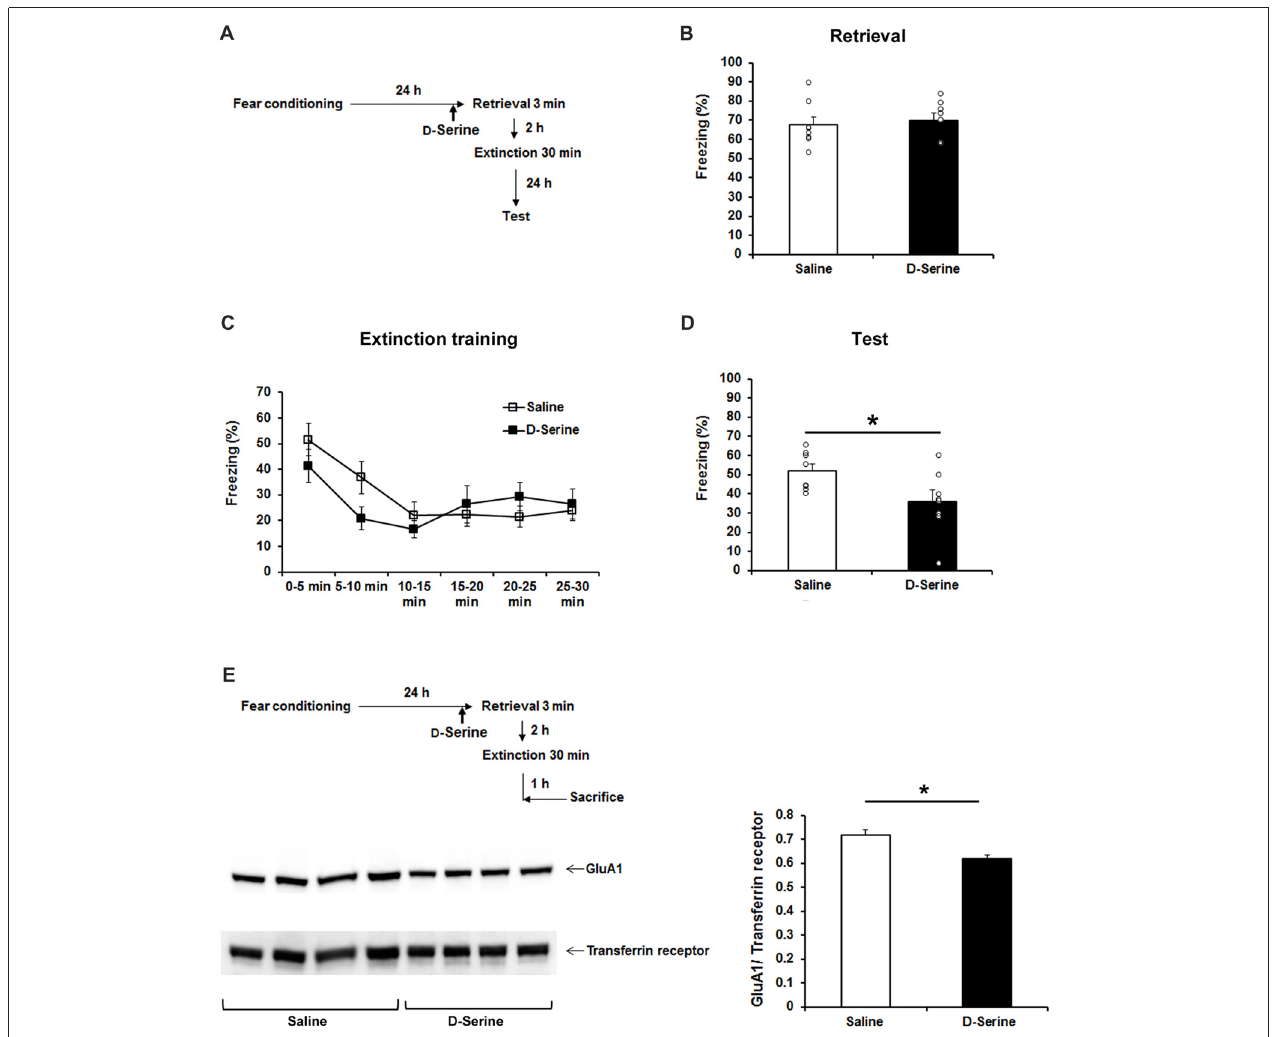
FIGURE 6 | D -Serine treatment rescues the deficit of P-RE in the SRRKO mice. (A) Experimental schedule for the behavioral rescue experiment. (B) D -Serine-treated SRRKO mice ( n = 8, D -Serine) exhibited similar levels of freezing compared with saline-treated SRRKO mice ( n = 8, Saline) during the 3-min retrieval session. (C) During the extinction training conducted 2 h after retrieval, there was no significant difference in within-session extinction between D -serine- and saline-treated SRRKO mice. (D) During the recall test of extinction memory, D -serine-treated SRRKO mice exhibited significantly lower levels of freezing than did the saline-treated SRRKO mice ( ∗ p < 0.05). (E) Western blot analysis revealed a significantly lower level of GluA1 in the synaptic membrane fraction of D -serine-treated SRRKO mice ( n = 4) than in saline-treated SRRKO mice ( n = 4) 1 h after P-RE ( ∗ p < 0.05). Data are presented as means ±